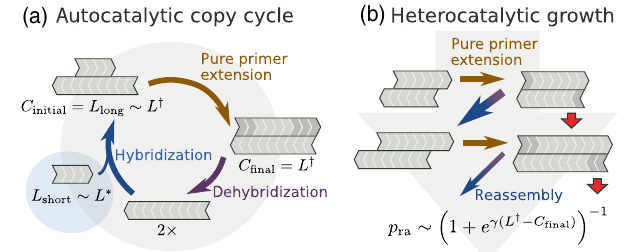
FIG. 7. Heterocatalytic (a) and autocatalytic (b) processes for the growth of strands. In the strongly nonequilibrium regime, extension cascades cover the available overhang of stable duplex and form longer fully hybridized strands. These long strands can then dehybridize and reassemble, thus creating new overhangs to be covered by extension cascades. The reassembly probability p is determined by the balance between dehybridization and outflux and decays to zero fast for L ≳ L †